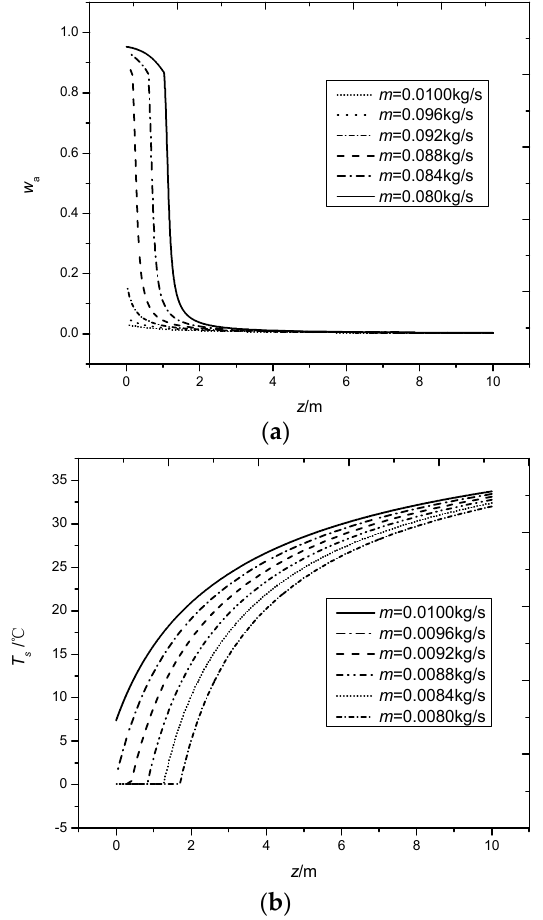
Figure 8. ( a ) Average non-condensable gas concentration of tube section along tube length; ( b ) Condensation temperature at initial fin of flat tube along length.